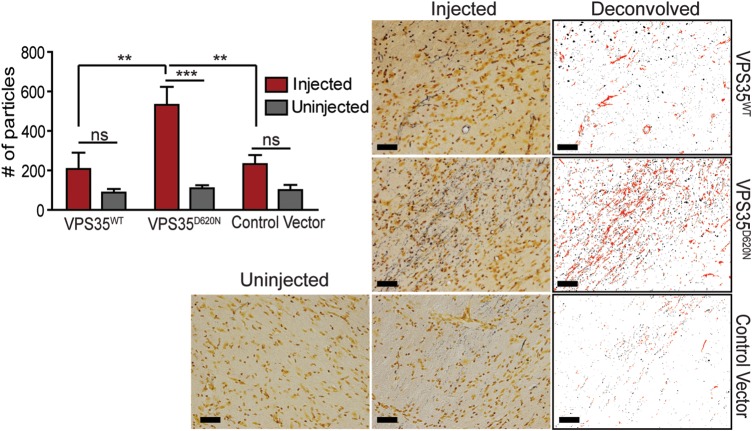
Nigral axonal degeneration induced by AAV2/6-mediated expression of D620N VPS35. Representative photomicrographs of substantia nigra sections processed with Gallyas silver stain, from rats injected with AAV2/6 vectors expressing human VPS35WT and VPS35D620N or a control vector, to reveal degenerating axons and nerve terminals (indicated in black). Scale bar: 50 μm. Images were subjected to deconvolution, color separation and filtering (circularity index ≤0.6 to remove nuclei/soma) using ImageJ to isolate black particles representative of neuritic processes and terminals for quantitation. Examples of particles analyzed are shown pseudocolored in red. Data are expressed as the number of black particles (silver-positive neurites/terminals) and bars represent the mean ± SEM (n = 6 animals/group). **P<0.01 or ***P<0.001 by one-way ANOVA with Tukey's post hoc analysis as indicated. n.s., non-significant.